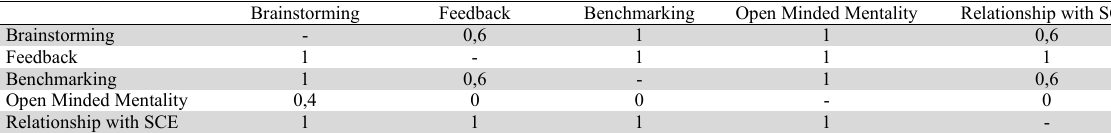
Credibility matrix